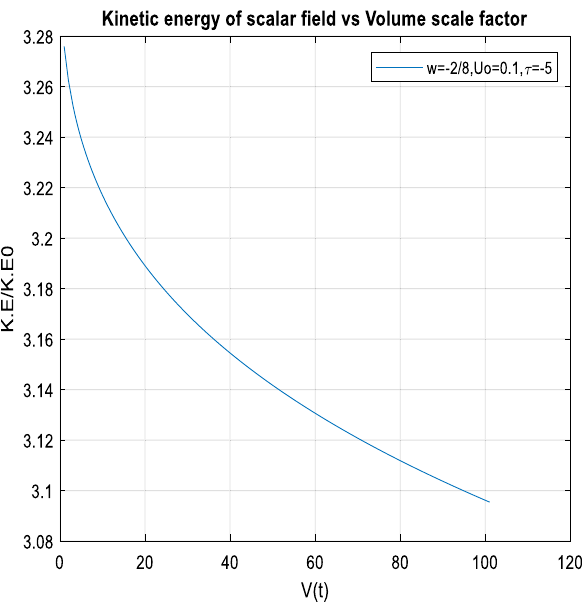
, U = 0 . 1 and τ = 0 8